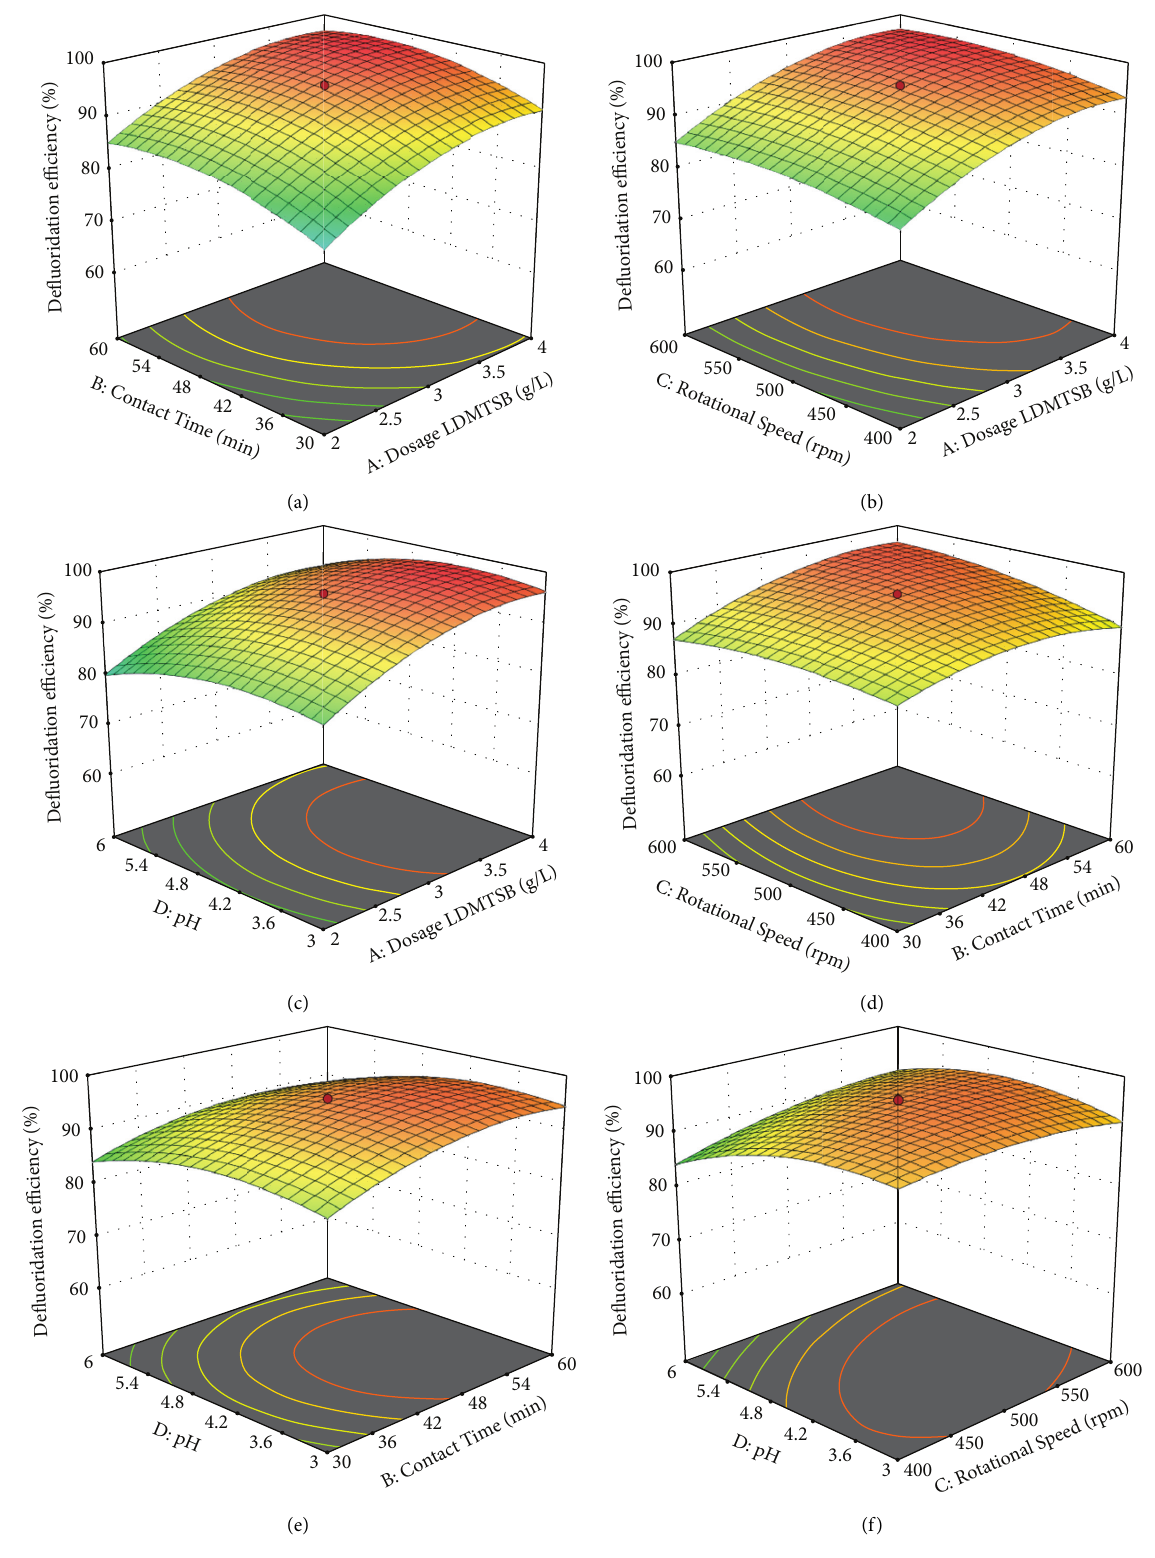
Figure 7: The 3D representation of defluoridation efficiency (%) by varying (a) contact time and dosage, (b) rpm and dosage, (c) pH and dosage, (d) rpm and time, (e) pH and contact time, (f) pH and